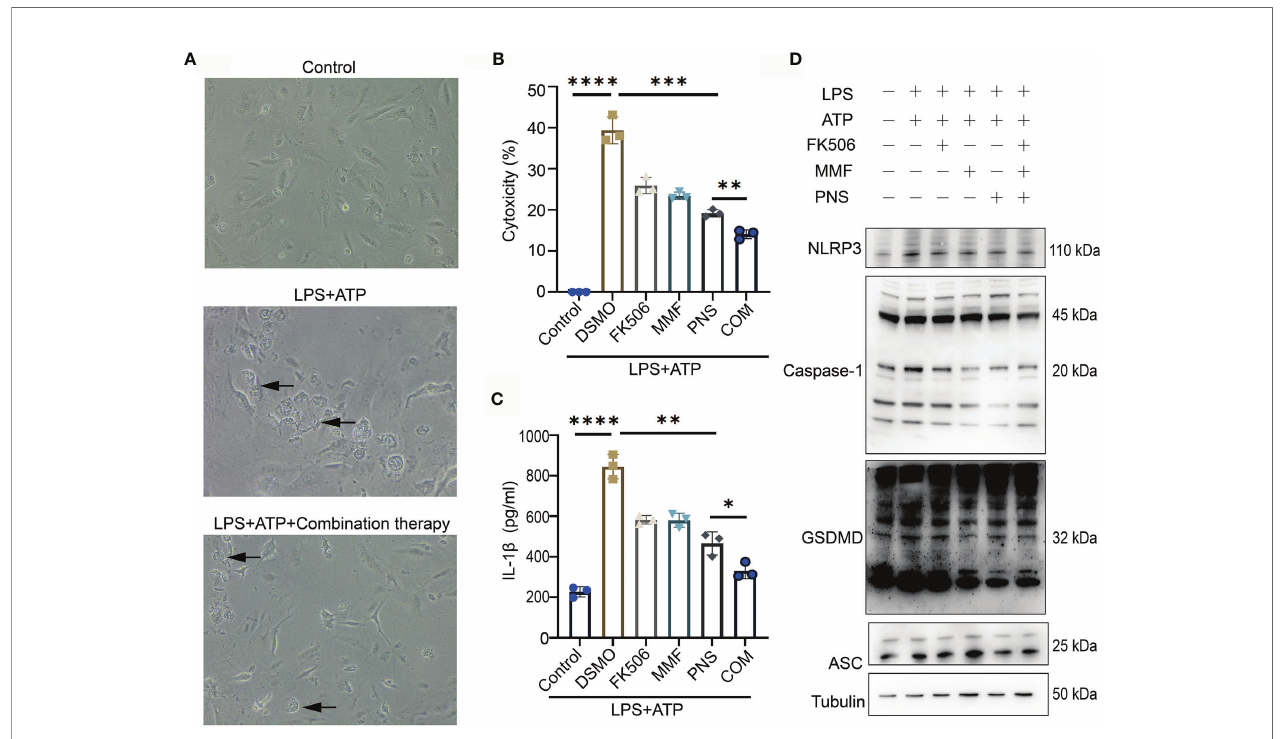
FIGURE 2 | Combination treatment ameliorates pyroptosis in podocytes in vitro . (A) Pyroptotic features were exhibited in cultured primary podocytes after incubated with LPS+ATP, and pretreated with combination treatment. Arrows indicated cells exhibiting pyroptotic-like features. (B) Supernatants from challenged cells were analyzed for cell death, as measured by LDH secretion. (C) Supernatants from the challenged cells were analyzed for IL-1 b release. (D) Immunoblotting analysis of NLRP3, caspase-1, GSDMD-NT and ASC expression after tacrolimus, MMF, prednisone or combination treatment after NLRP3 in fl ammasome activation. * p < 0.05; ** p < 0.01; *** p < 0.001; **** p < 0.0001. LDH, lactate dehydrogenase; DSMO, Dimethyl sulfoxide, FK506, tacrolimus; MMF, mycophenolate mofetil; PNS, prednisone; COM, combination therapy; ASC, apoptosis-associated speck like